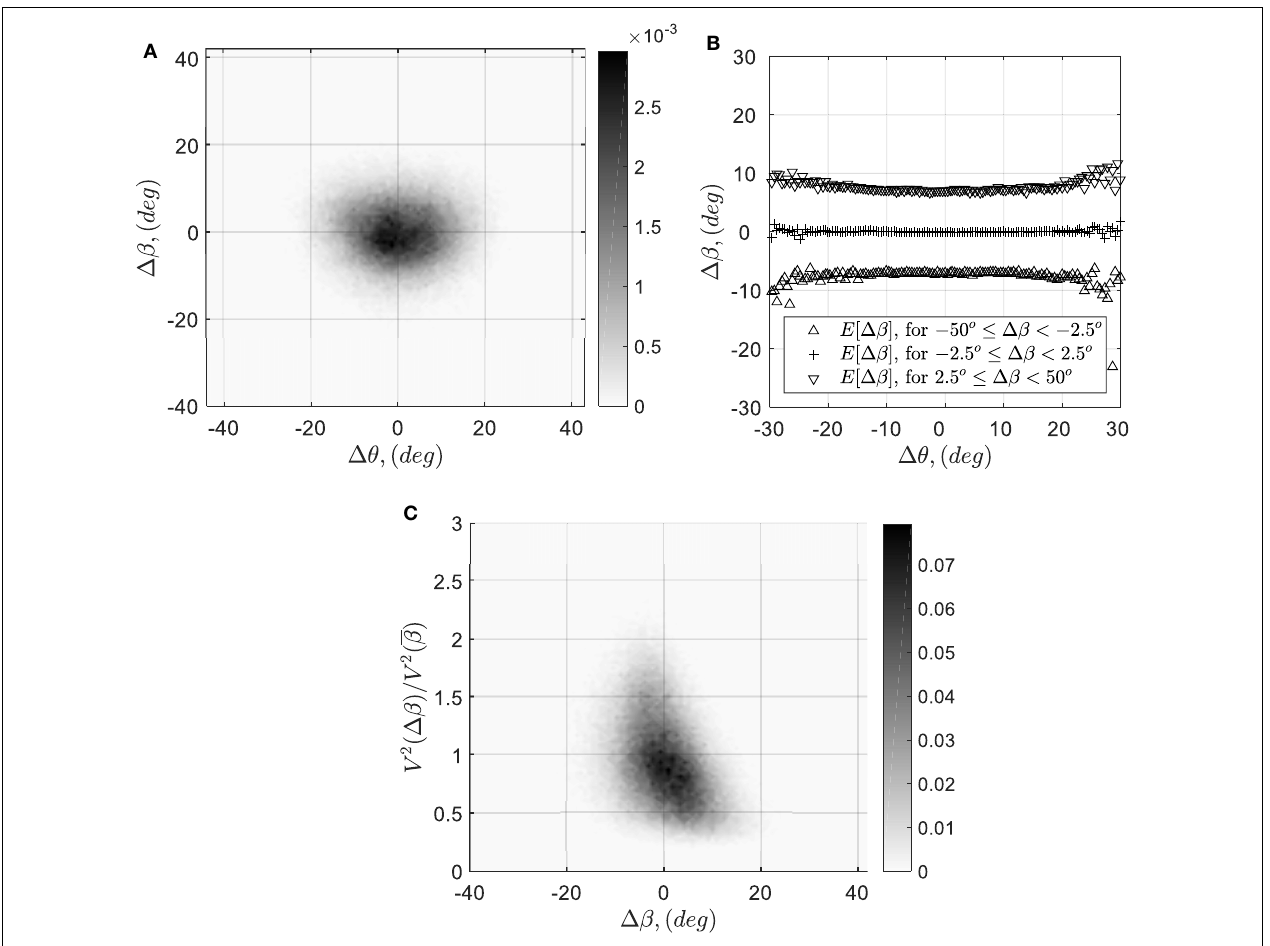
( ( ) ) (cid:22) β Δβ ; V 2 ( Δβ ) = V 2 obtained from velocity measurement without building in